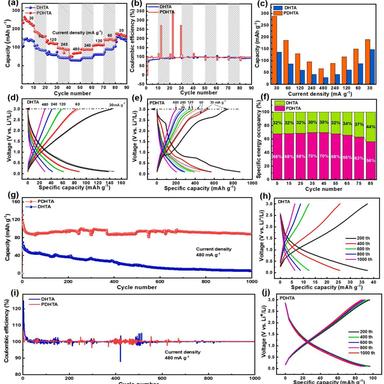
(a, b) Rate performance and Coulombic efficiency comparison of DHTA and PDHTA at different current densities; (c) Discharge specific capacity comparison of DHTA and PDHTA at different current densities; (d–f) Rate performance charge-discharge curves and discharge specific capacity fraction at different cycle numbers for DHTA and PDHTA; (g, i) Cycle performance and Coulombic efficiency of DHTA and PDHTA at 480 mA g− 1 ; (h, j) Charge-discharge curves of DHTA and PDHTA over different cycle numbers.